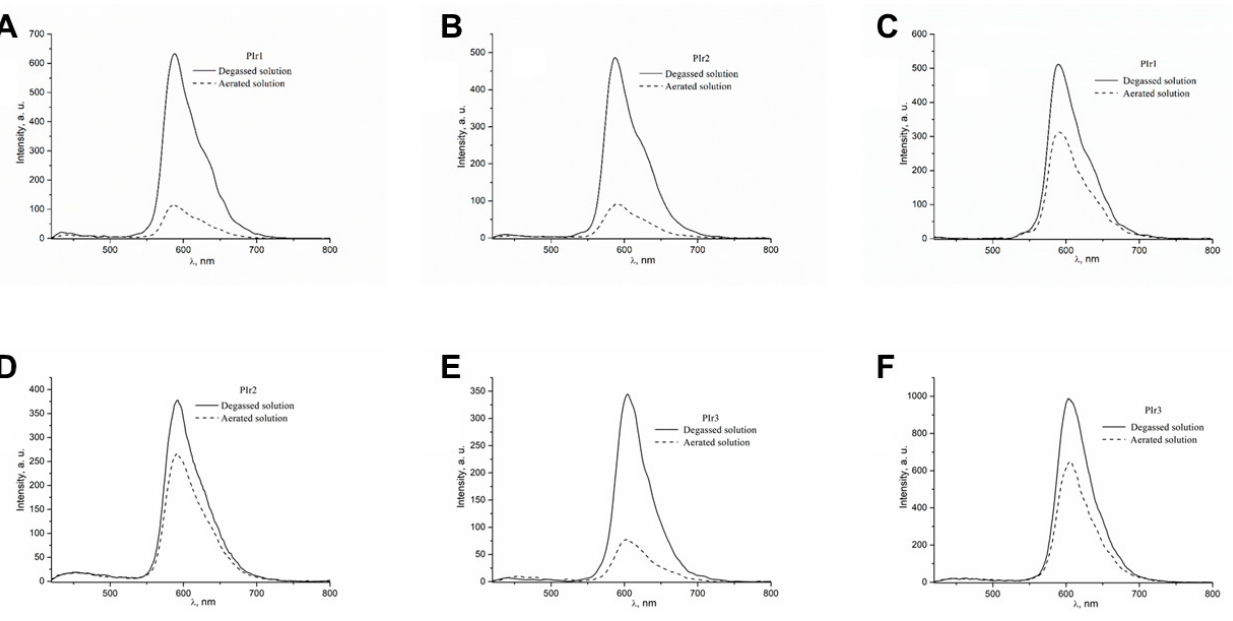
Figure 3. Photoluminescence spectra of PIr1–PIr3 in ( A , B , E ) CH 2 C l2 solution and ( C , D , F ) aqueous solution at room temperature. λ ex = 360 nm.